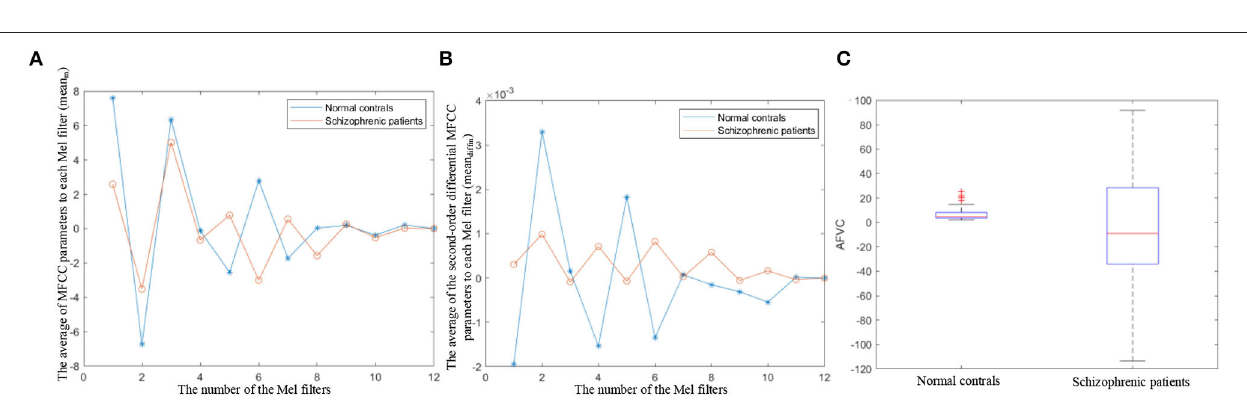
FIGURE 6 | (A) The probability density function curves of the first-order difference of the intensity means sequence. (B) Boxplot of PIVD.